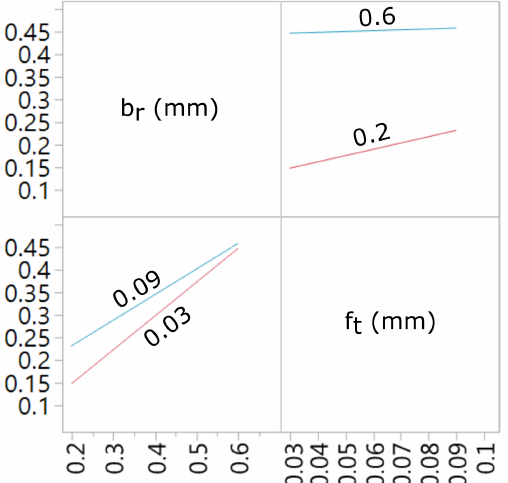
Figure 12. Interaction plot for a model with the Sa output field.